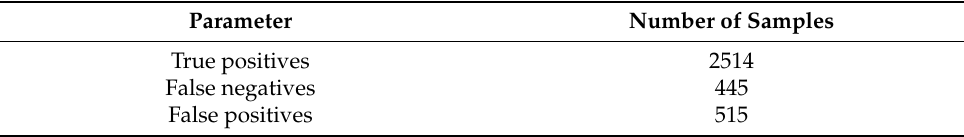
Table 9. Results of each classified instance of the